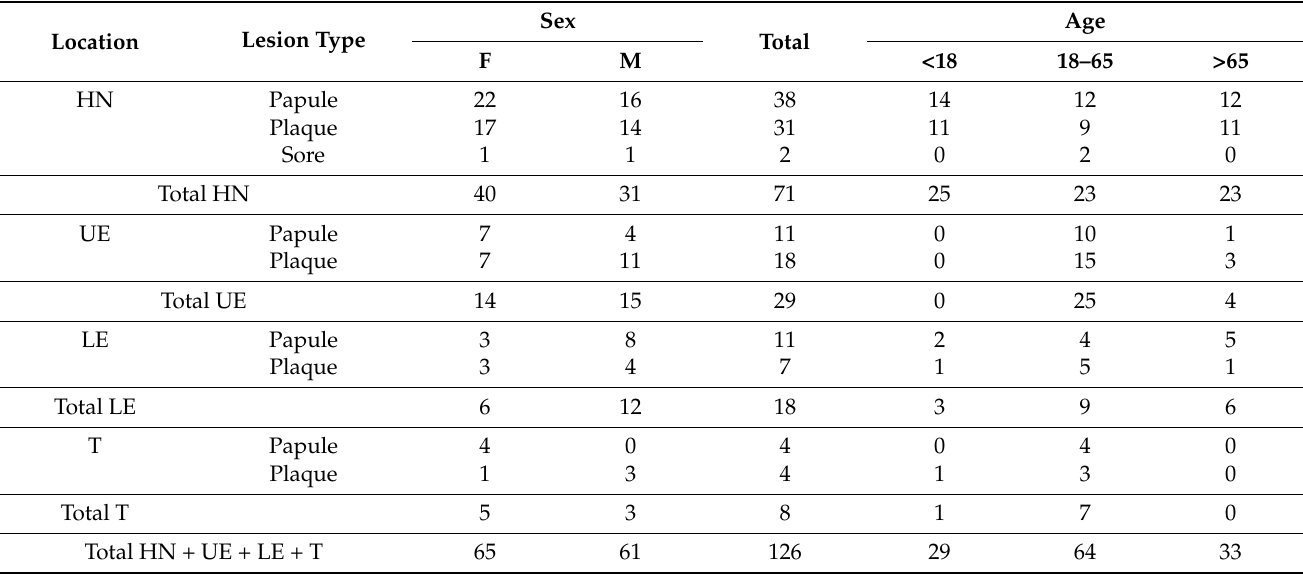
Table 5. Location and type of lesions according to the sex and age of the patients ( n =